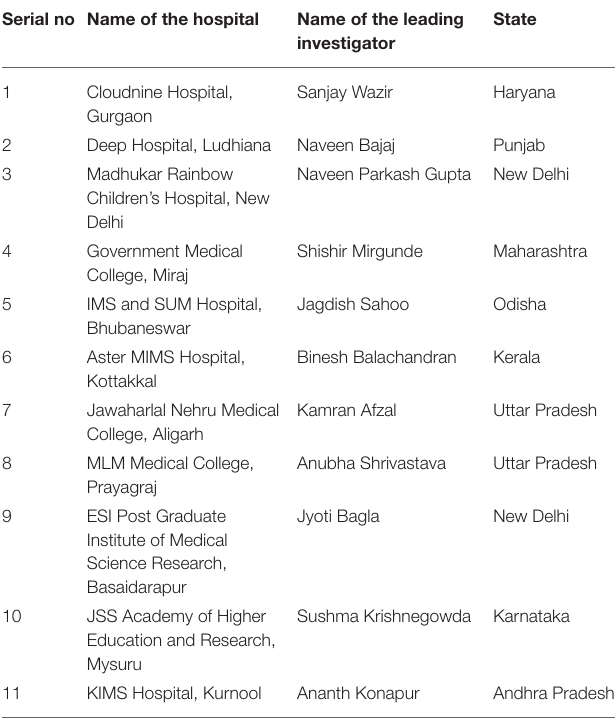
TABLE 1 | List of participating centers along with the name of the leading investigator. Serial no Name of the